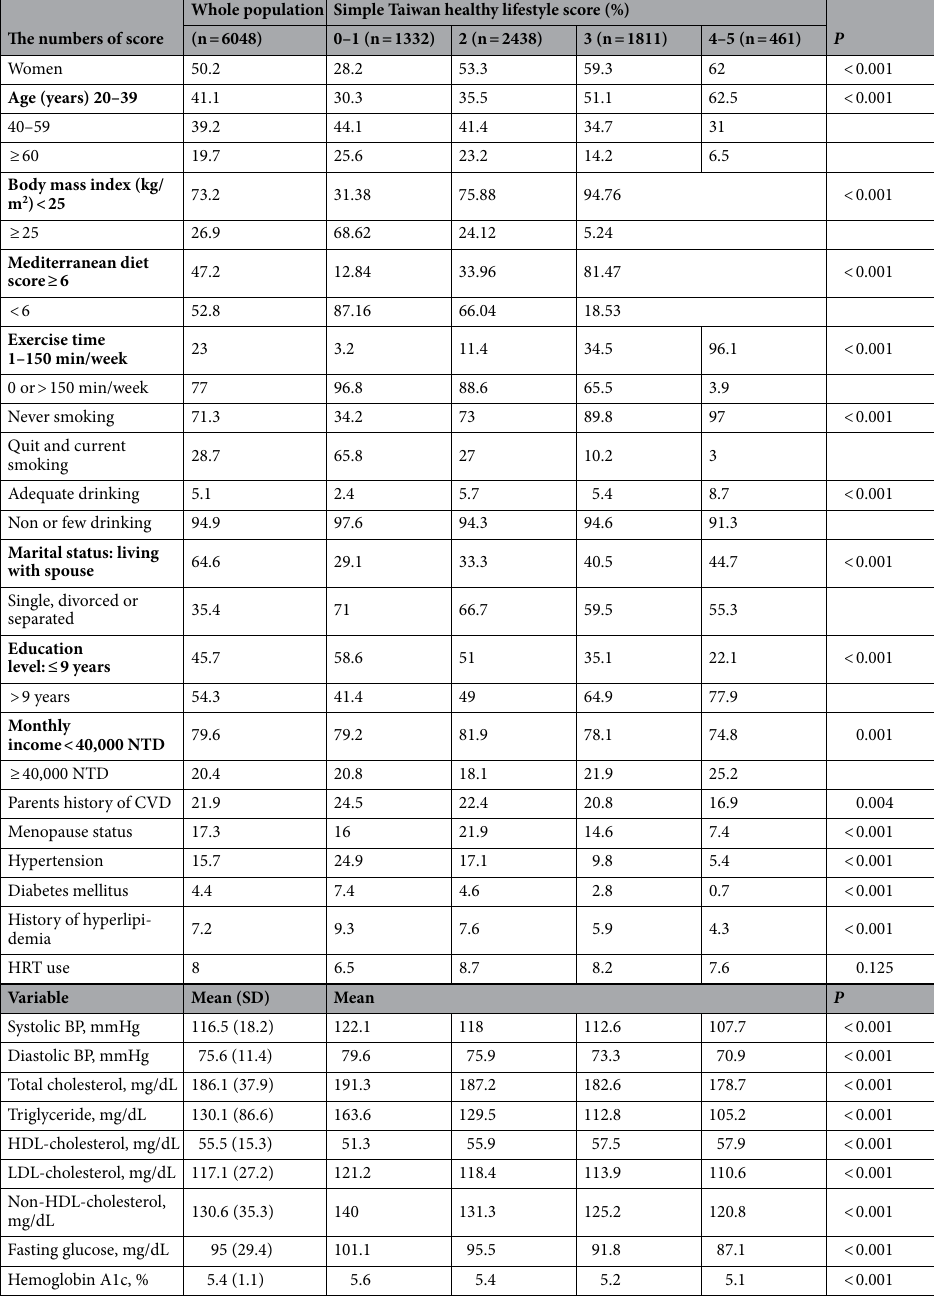
Table 1. Basic characteristics of the study participants at baseline, specified by adherence numbers of healthy lifestyle scores according to the simple Taiwan healthy lifestyle score (0 ~ 5 points). MHL Mediterranean diet related healthy lifestyle score, SD standard deviation, BP blood pressure, HDL high density lipoprotein, LDL low density lipoprotein, ANOVA and the chi-square tests were used to compare the means and proportions among